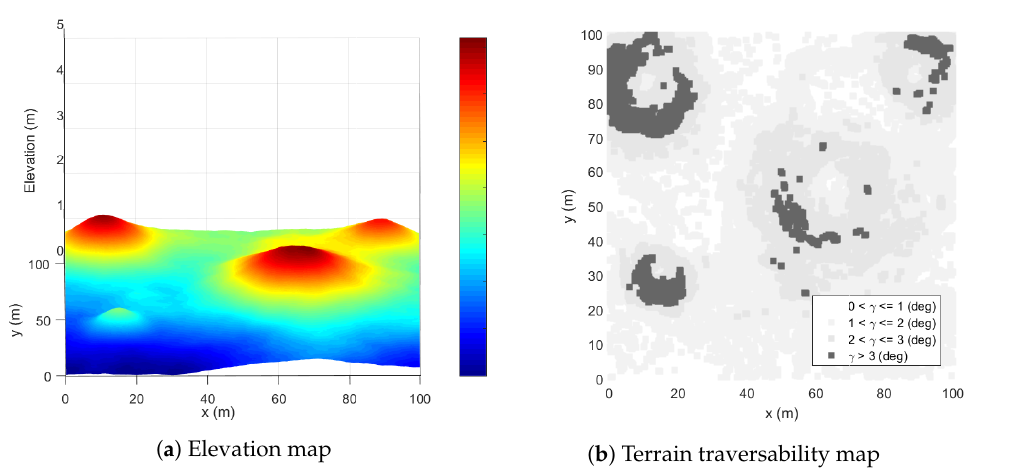
Figure 6. Testing environment. Table 3. Simulation parameters for testing.